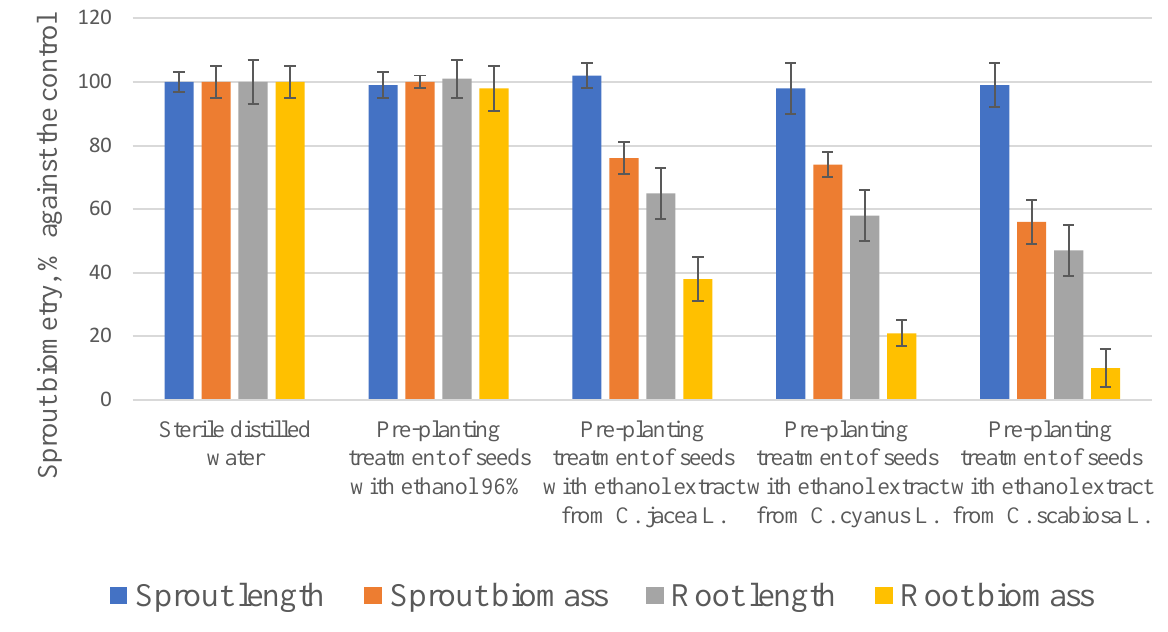
Figure 2. How pre-planting treatment of seeds with flower extracts (1 mg/mL) affected the biometry of garden cress sprouts compared to the controls.